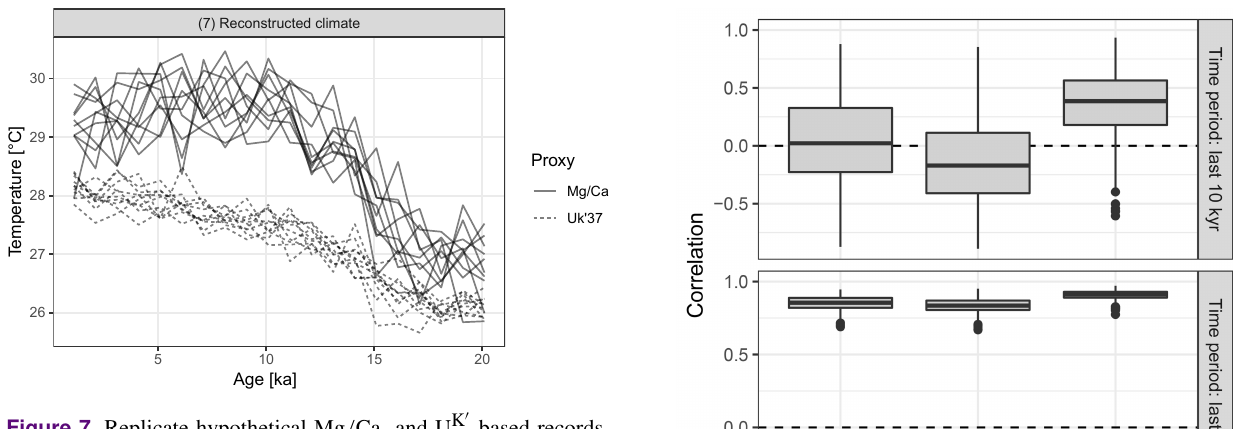
Figure 7. Replicate hypothetical Mg / Ca- and U K The two proxy types sample different parts of the seasonal cycle. Ten replicate records are shown for each proxy.